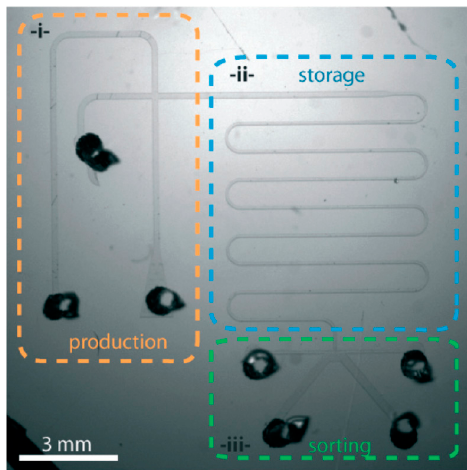
Figure 2. The worm chip developed by Aubry et al. [38], with its different modules. Reprinted with permission from the Royal Society of Chemistry.